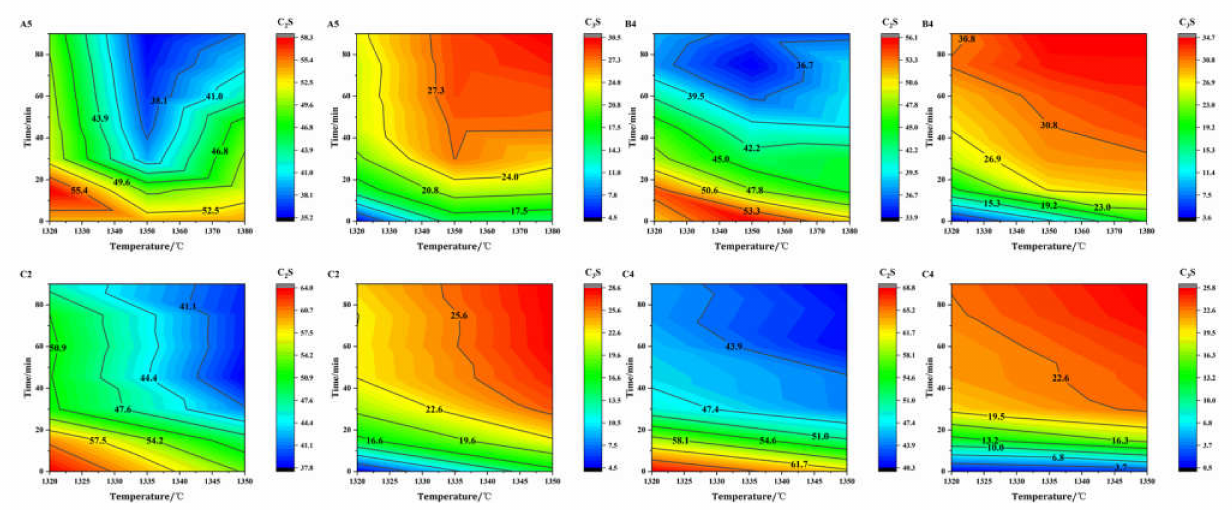
Figure 8. Contours of C 2 S and C 3 S contents in different clinkers with calcination time and